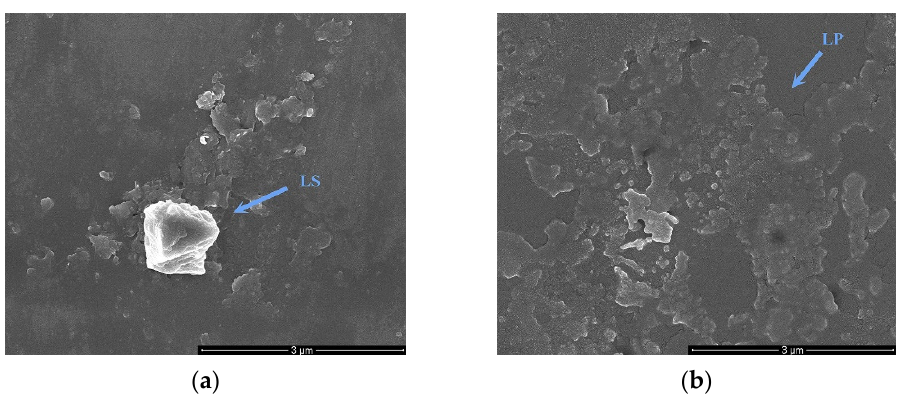
Figure 3. The scanning electron microscopy (SEM) image of lotus seed starch ( a ) and protein ( b ) (×50,000).